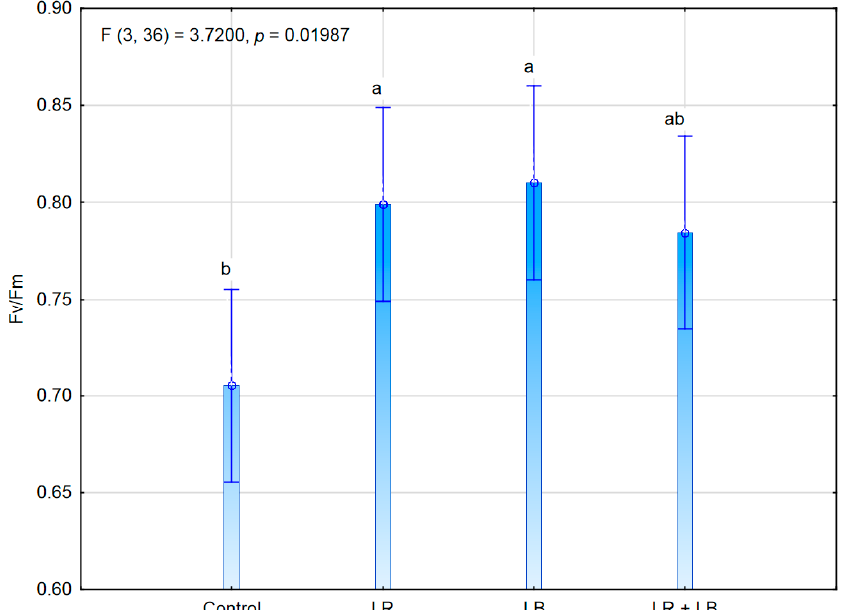
Figure 5. Effect of the irradiation type on the Fv/Fm parameters. Different letters indicate the significant differences at p < 0.05.